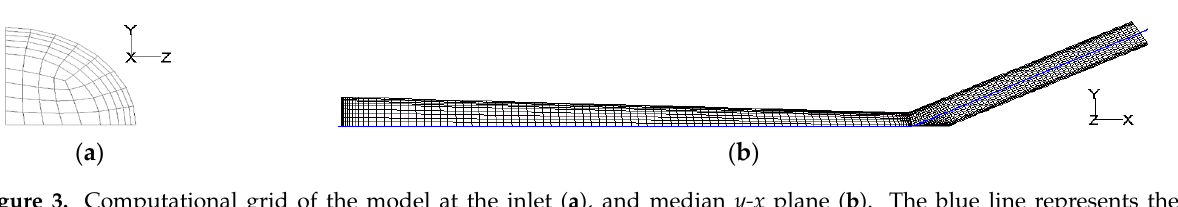
Figure 3. Computational grid of the model at the inlet ( a ), and median y-x plane ( b ). The blue line represents the axial direction.